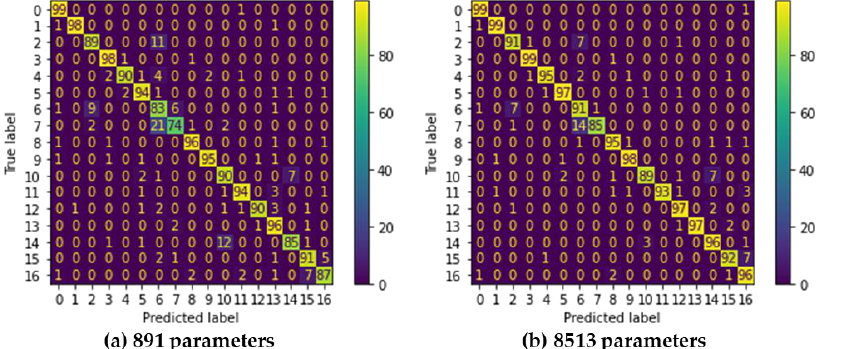
Figure 12. Confusion matrices of two Pareto Fronts.